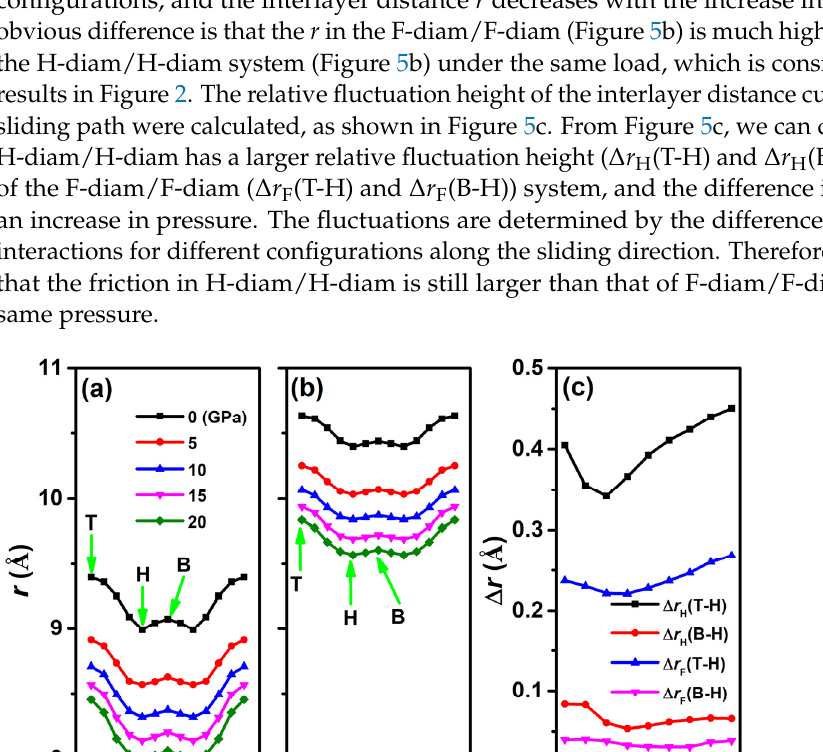
Figure 5. Interlayer distances r as a function of sliding distance s (in unit of √ 3 times of lattice con- stant, s = 0, 0.33, and 0.5 represent top (T), hollow (H), and bridge (B) stackings, respectively) along the maximum path (see Figure 4a) under different normal pressures P. ( a ) H-diam/H-diam and ( b ) F-diam/F-diam systems. ( c ) The difference in r between top and hollow ( Δ r H (T-H) for H-diamane, Δ r F (T-H) for F-diamane), bridge, and hollow stackings ( Δ r H (B-H) for H-diamane, Δ r F (B-H) for F- diamane) as a function of P for both systems.